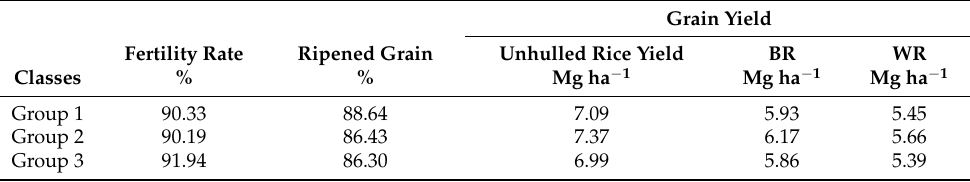
Table 7. Fertility rate, ripened grain, and grain yield of unhulled rice, brown rice (BR), and white rice (WR) of each cluster.